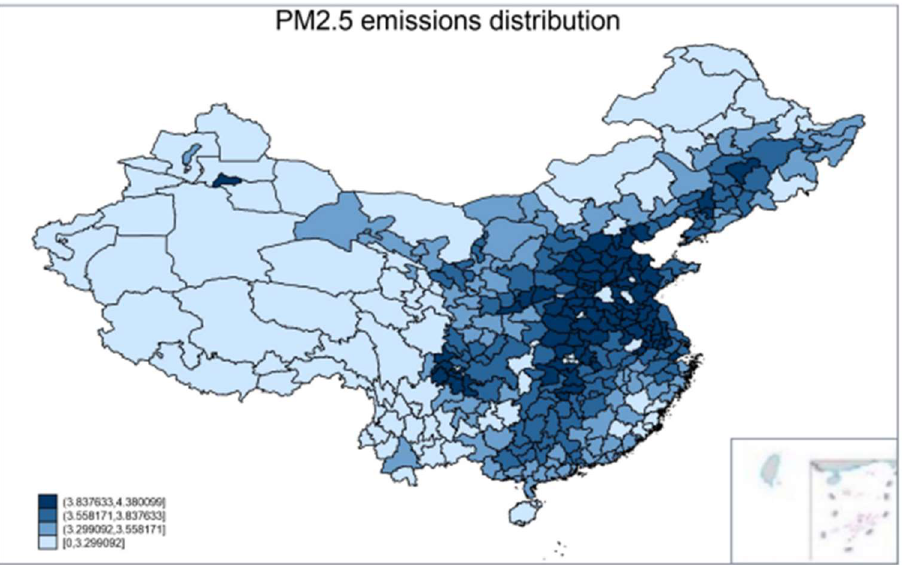
Figure 3. Air pollution distribution. Note: The arithmetic mean value of air pollution (2010–2020) is adopted.